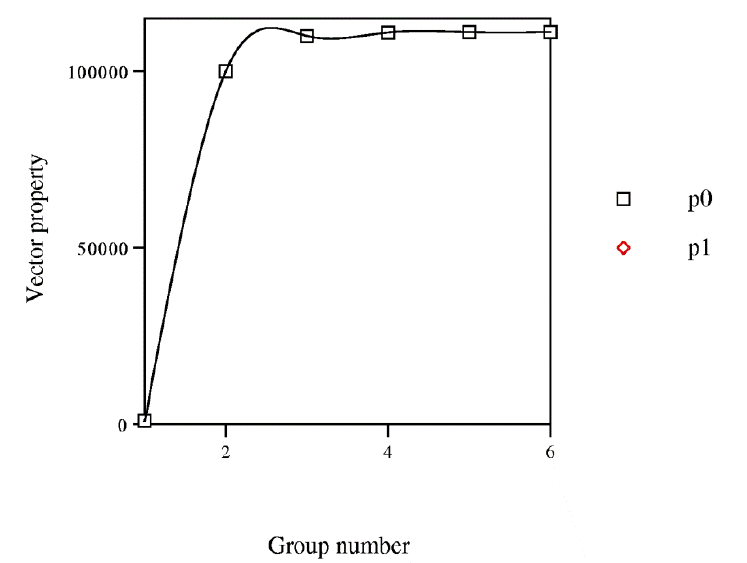
Figure 12. Variation of the vector property P ( p ) of the pesticides versus group